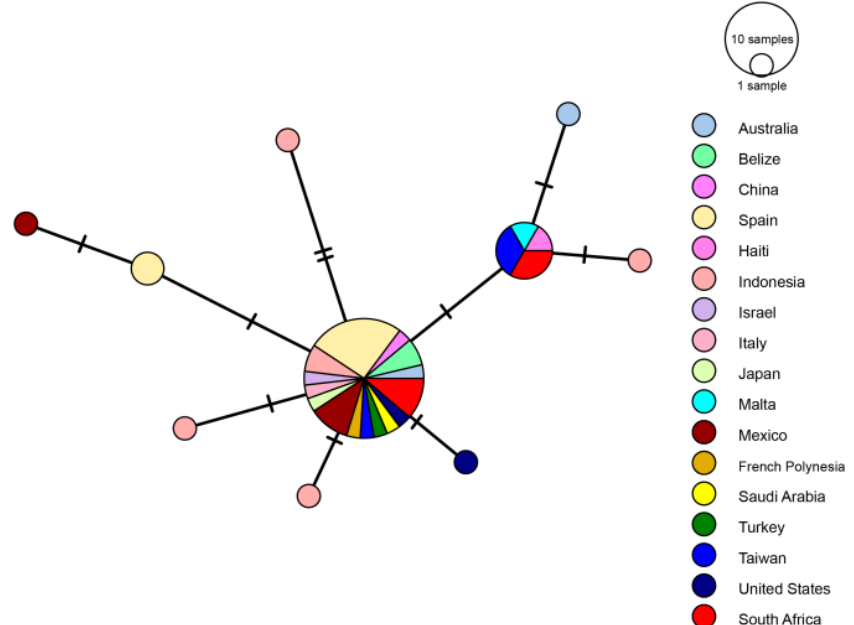
Figure 2. Haplotype network of COI sequences of Kyphosus vaigiensis ( N = 42). Median-joining network ( ε = 0) created in PopART v1.7. Each circle represents a haplotype; the size of circles corresponds to the number of individuals with the haplotype. Colours indicate sampling sites. Bars indicate the number of mutations between two haplotypes. The samples from Spain are of Atlantic origin (Galicia), and those from the United States come from Hawaii.